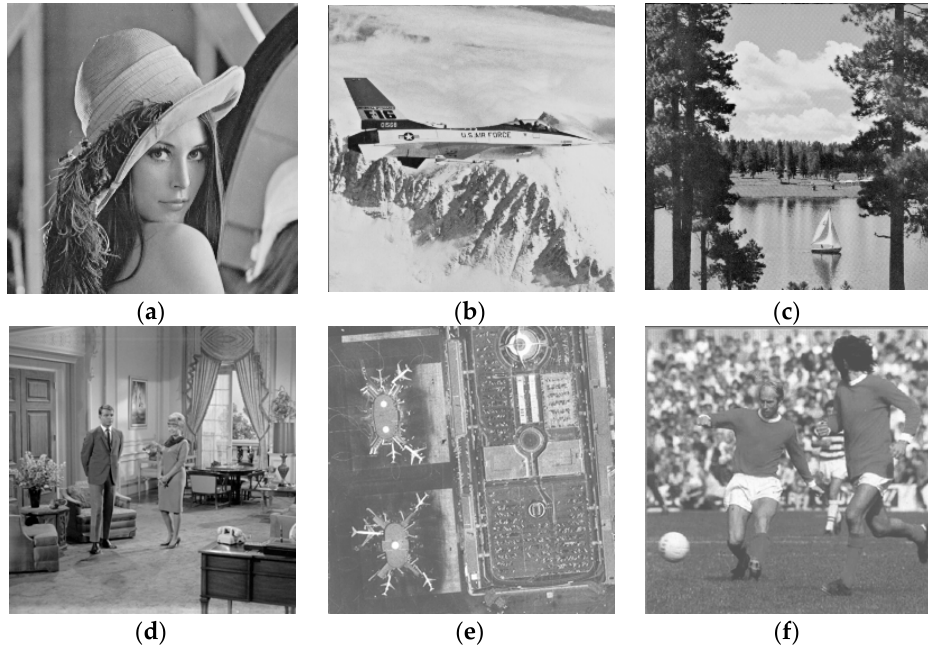
Figure 5. Test images: ( a ) Lena; ( b ) Airplane; ( c ) Boat; ( d ) Couple; ( e ) Lax; ( f ) Best_cha.